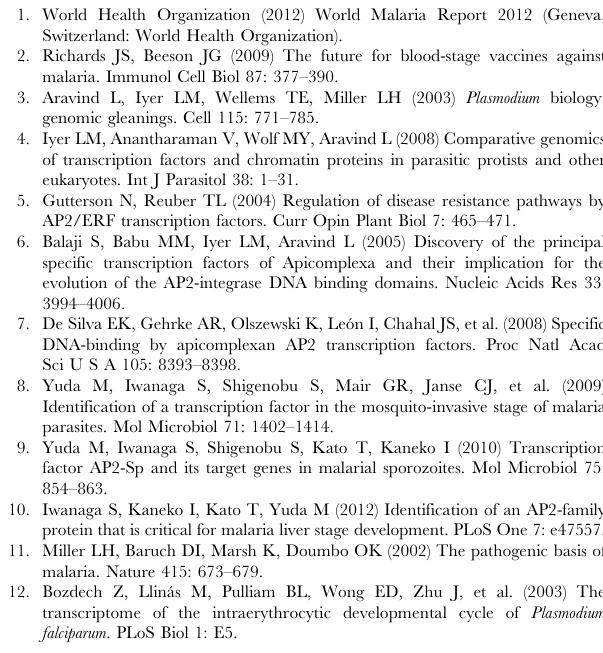
Figure S3 Amino acid sequence of the verified PREBP, PF3D7_1011800. The deduced molecular weight of PF3D7_1011800 is 132 kDa. The peptides detected in mass spectrometry are indicated with gray shading. The predicted K- homology (KH) domains are indicated with open boxes. The start and end points of the partial , 60 kDa recombinant protein, which was expressed in the transgenic parasite, are indicated by arrows. (TIF) Figure S4 Patterns of expression of PREBP mRNAs in P. falciparum cells during the erythrocytic stage. Parasite cultures were tightly synchronized, and parasite-infected erythro- cytes were harvested at the indicated times for total RNA extraction and cDNA synthesis. Images of various stages of parasite growth at indicated times are shown in the lower panel. Time 0 corresponds to the final synchronization by D-sorbitol treatment. Real-time quantitative RT-PCR was performed with cDNA templates, and the values recorded were normalized to the amount of 18 S rRNA in each sample measured in the same RT- PCR run. Patterns of expression of pf1-cys-prx mRNAs which were measured using the same cDNA sample are indicated as a sub- panel within the main panel. Figure S5 Expression level of pf1-cys-prx in parasites that overexpress the central , 60 kDa region of PREBP.